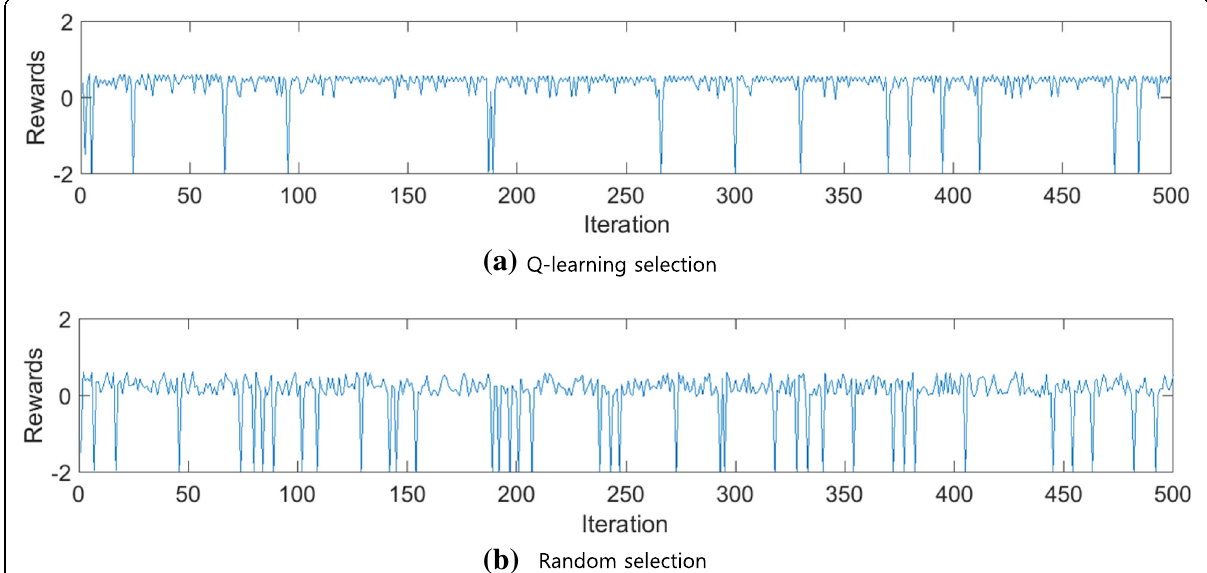
Fig. 22 Rewards for a Q-learning and b random channel selection according to iteration (DDR = 40 kbps)